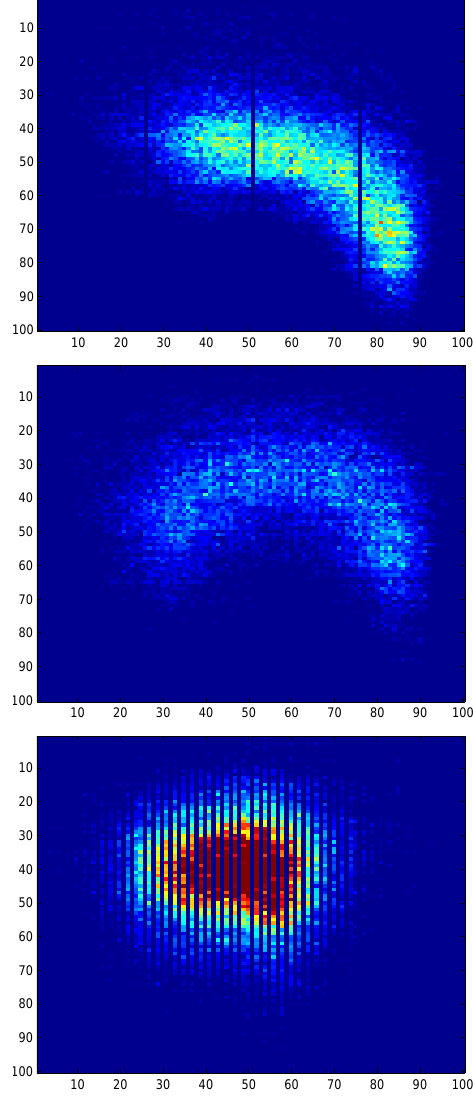
Fig. 12. Binned phase planes H¨older exponents/temperatures for maximum temperatures at Lees Ferry, Arizona, from 1 April 1916 through 31 December 2011 (middle), and mean temperature from 1 January 1893 through 31 December 2011 at Corning, Arkansas, (top) and Santa Cruz, California (bottom).